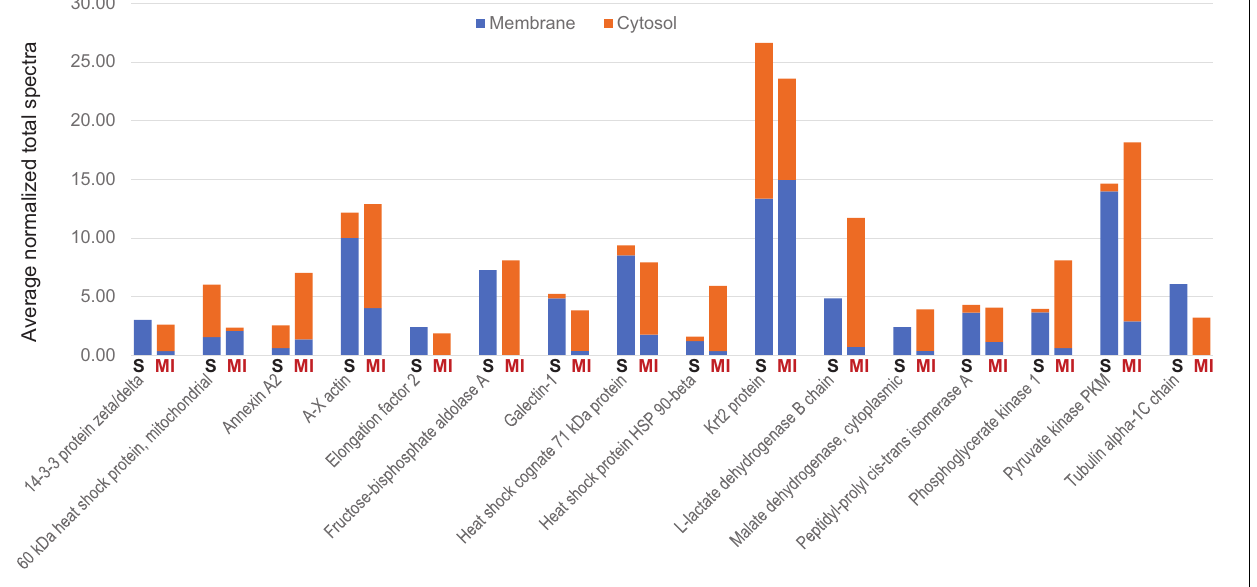
FIGURE 6 | MI alters the subcellular distribution of proteins from systemically administered MetRS ∗ MSC-Exos. MetRS ∗ MSC-Exos were injected into the tail vein of mice 24 h after MI induction or Sham surgery. Animals were euthanized 12 h after exosome administration, and protein extracts from the left ventricle were separated into membrane and cytosolic fractions; then, the ANL-labeled MetRS ∗ MSC exosomal proteins in each fraction were isolated via click-catalyzed alkyne-agarose capture and identified via LC-MS. The abundance of each of the 16 selected canonical exosomal proteins in the membrane and cytosol fractions of hearts from Sham (S) and MI animals was expressed as normalized average spectra from 3 independent